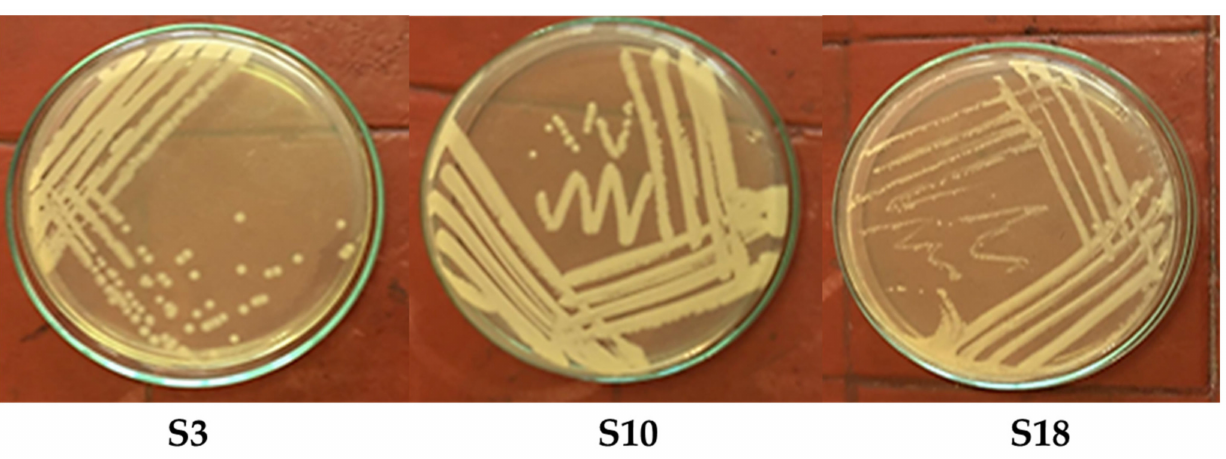
Figure 1. Bacterial growth of Pseudomonas aeruginosa (S3), Klebsiella pneumoniae (S10), and Klebsiella variicola (S18) onto MSM plates amended with 500 mg/L